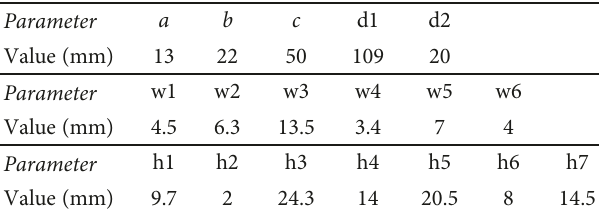
Figure 6: Geometry of the proposed DRA unit (a) in 3D view, (b) side view for SMA connector location, and (c) top view for matching circuitry connection of DRA. Table 1: Design parameters of the proposed